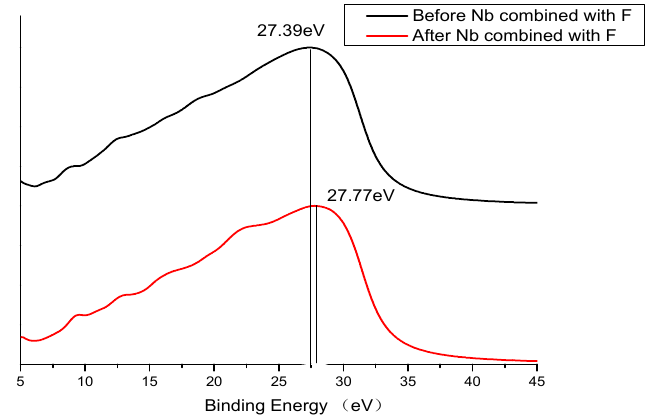
Figure 12. EELS spectrum of Nb 3d orbital in FeNb2O6(110) system before and after adding HF. As shown in Figure 13, before and after the combination of the F and Fe atoms, the main peaks of the EELS spectrum shifted to two states, and the EELS spectrum showed that the binding energy of both states increased. The more the number of electrons lost in oxidation, the greater the increase. Before combining with F, the core-level energy peak of Fe 2p orbital was 0.18 eV. After combining with F, the main peak shifted to 0.54 eV with an increase of 0.36 eV. As the number of F atoms bound to Fe increased, the main peak shifted to 1.49 eV, the core-level energy increased by 1.31 eV.